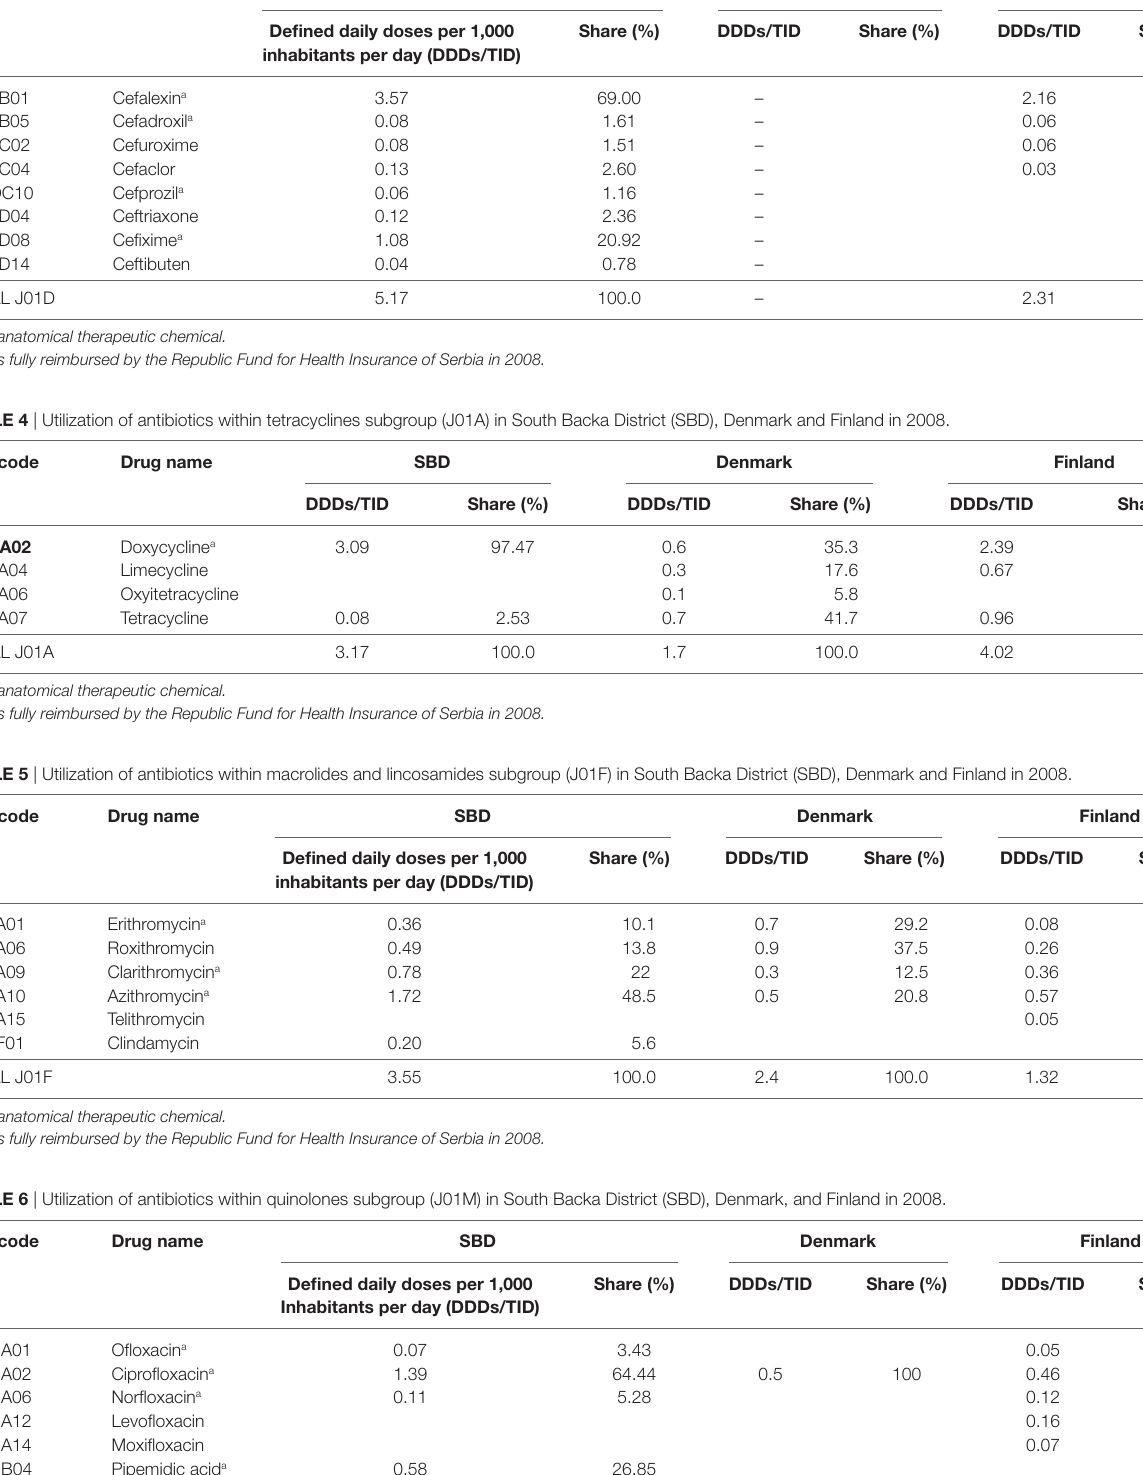
TaBle 3 | Utilization of cephalosporins (J01C) in South Backa District (SBD), Denmark, and Finland in 2008. aTc